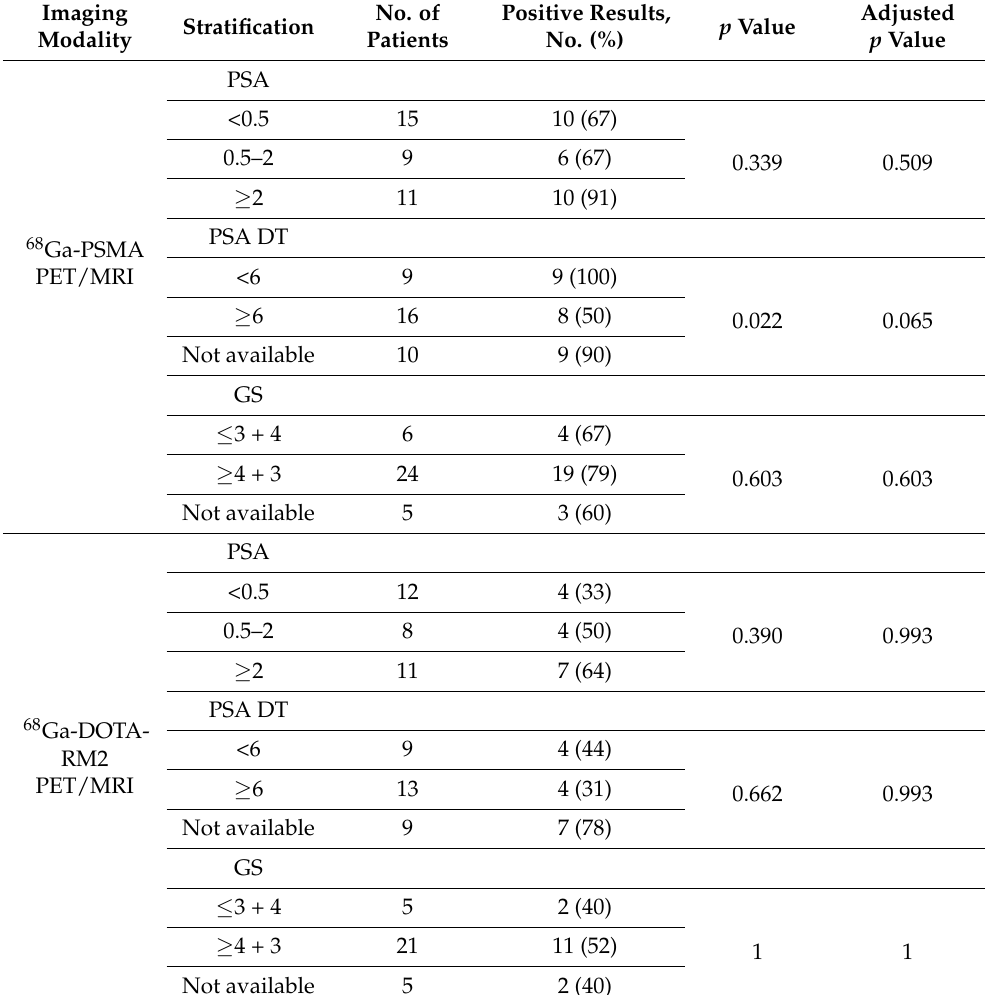
Table 3. Correlations between 68 Ga-PSMA and 68 Ga-DOTA-RM2 detection rates and clinical data on a patient basis.